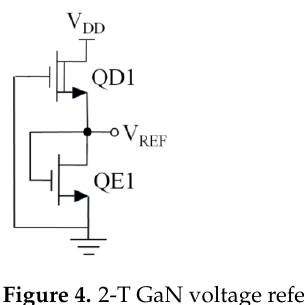
Figure 4. 2-T GaN voltage reference [31].